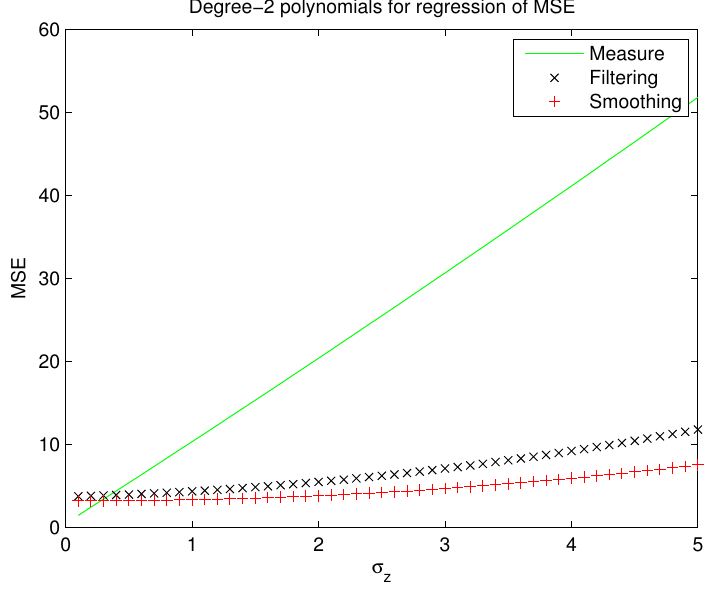
Figure 15. Percentage of distance with respect to the lateral optimum position under ∈ { 0 . 1 , 1 , 5 } ), for J measurement noise ( σ z D 2